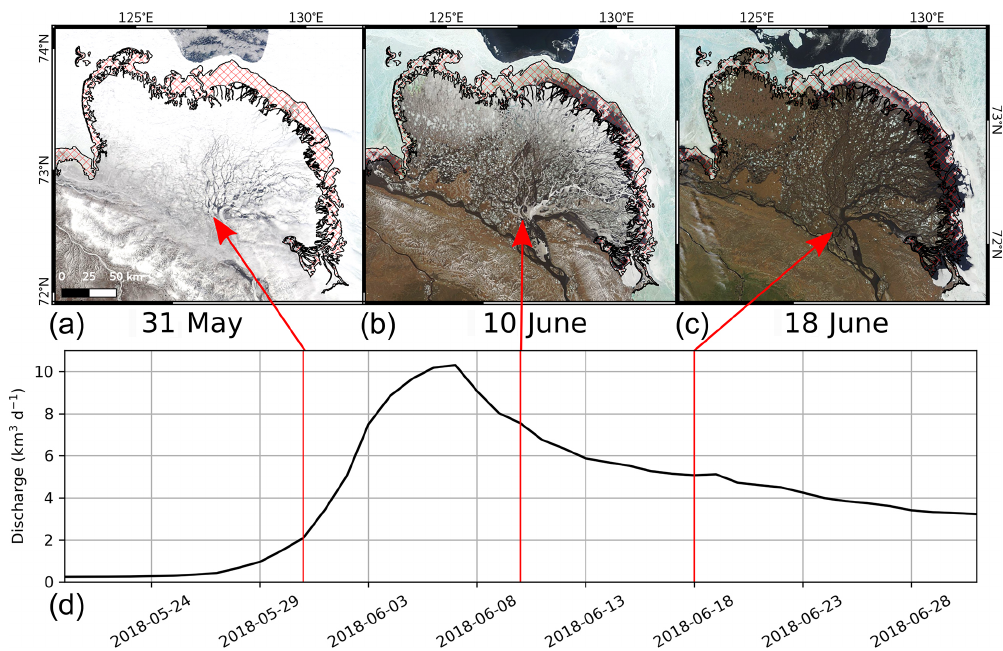
Figure 2. Satellite imagery of the Lena Delta from 2018 showing the delayed breakup of bottom-fast ice on the ramp feature. The upper panels (a–c) show the imagery of the Lena Delta. The hash pattern in red marks the location of the ramp, and (a) , (b) , and (c) correspond respectively to the start, middle, and completion of ice breakup in the delta itself. The corresponding dates and discharge (measured at Kyusyur station and corrected for the distance to the Lena Delta; Juhls et al., 2020) are shown in (d) , marked by the red arrows. Satellite imagery is acquired by the Moderate Resolution Imaging Spectroradiometer (MODIS) and obtained from NASA